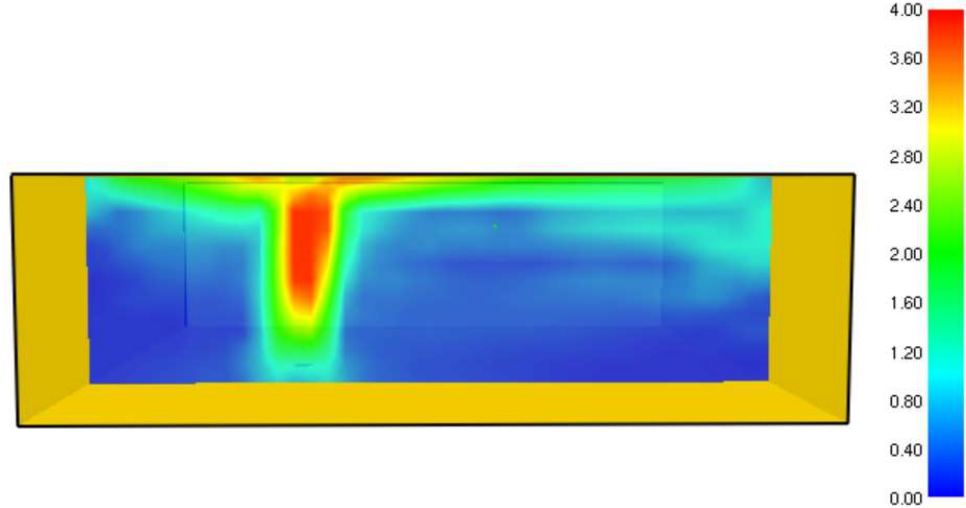
Figure 5. Velocity field (m/s) of the Heptane jet fire at t = 79.9 s.